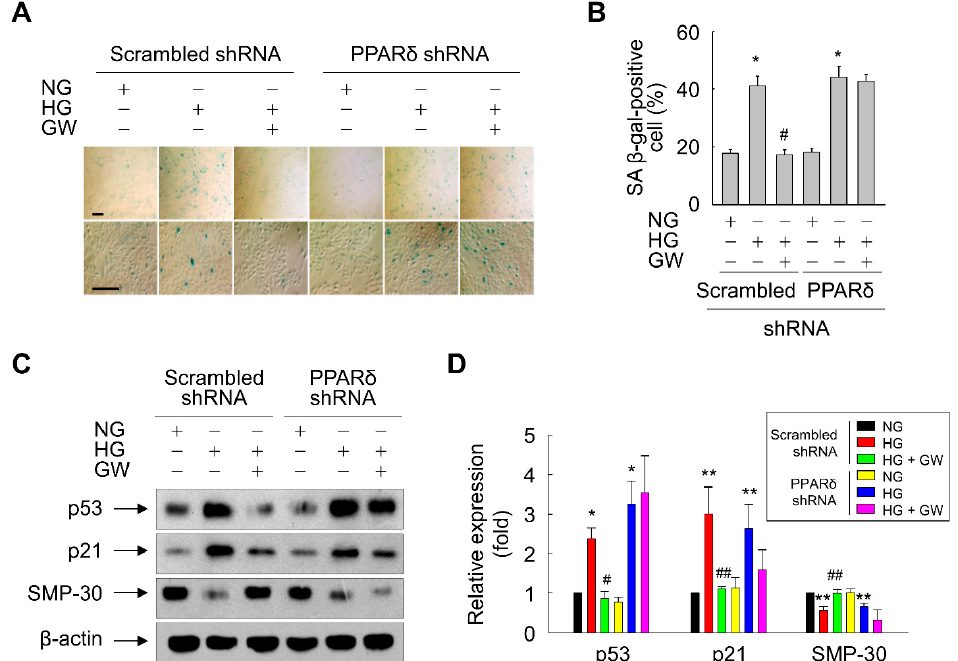
Figure 5. Transduction of PPAR δ -targeting shRNA abolishes the effects of GW501516 on HG-in-duced senescence and expression of senescence-associated proteins in ARPE-19 cells. ( A , B ) Cells stably expressing scrambled or PPAR δ -targeting shRNA were pretreated with 100 nM GW501516 (GW) for 24 h and then exposed to NG (5.6 mM) or HG (30 mM). After incubation for 48 h, SA β -gal staining was performed ( A ) and SA β -gal-positive cells were quantified in at least six fields ( B ). Scale bars indicate 100 μ m. ( C , D ) Parallel immunoblotting for p53, p21, and SMP-30 ( C ) and densitometric quantification ( D ) were performed. Data are expressed as means ± S.E. ( n = 3 for Western blotting and n = 6 for SA β -gal staining). * p < 0.01, ** p < 0.05 compared with the NG-treated group. # p < 0.01, ## p < 0.05 compared with the HG-treated group.